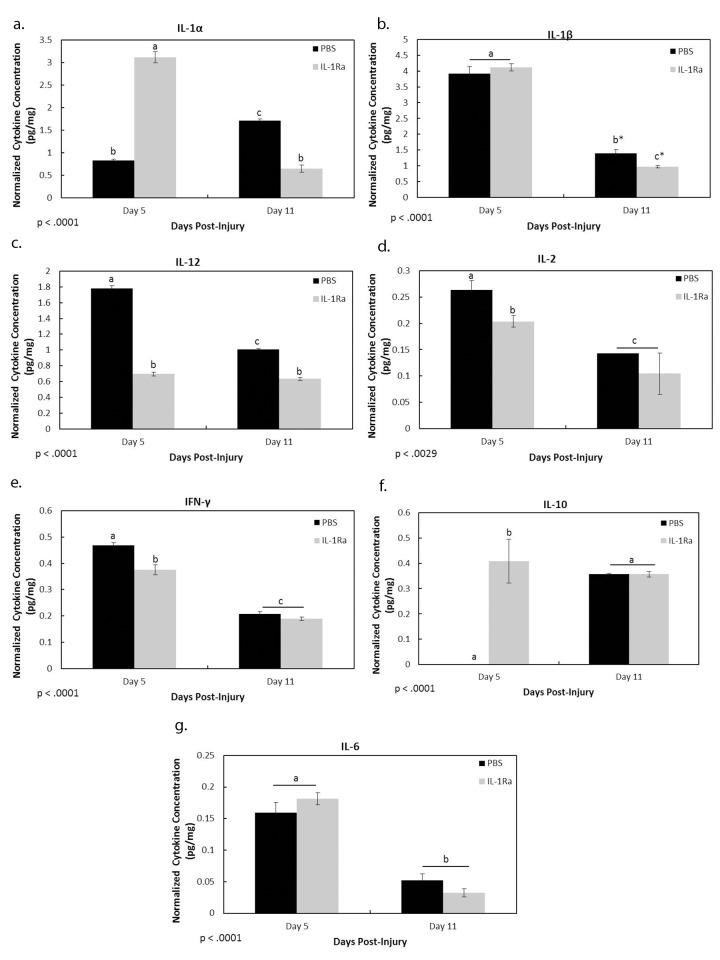
Luminex results of cytokines regulated by IL-1Ra.Graphs show the effects of PBS and IL-1Ra on MCL-derived IL-1α (a), IL-1β (b), IL-12 (c), IL-2 (d), IFN-γ (e) IL-10 (f), and IL-6 (g) production. Blockade of the IL-1 activation resulted in an accumulation of IL-1α (a) and IL-1β (b). By day 11, inhibition of the IL-1R resulted in a down-regulation of IL-1α (a) and tended to decrease IL-1β (b; p = .056). IL-1Ra significantly decreased the pro-inflammatory cytokines, IL-12 (c), IL-2 (d), and IFN-γ (e) on day 5. IL-12 levels remained significantly different after IL-1Ra on day 11. The anti-inflammatory cytokine, IL-10 was up-regulated at day 5 after IL-1 inhibition (f). IL-6 was not significantly influenced by treatment (f). Beneath graph, p value indicates ANOVA results. a,b,c indicates within a graph, bars without a common superscript letter differ (results of Fisher’s LSD post-hoc pairwise analysis, p<.05). *indicates p value.056. Values are expressed as normalized cytokine concentration (ng cytokine/mg tissue weight) ± S.E.M.